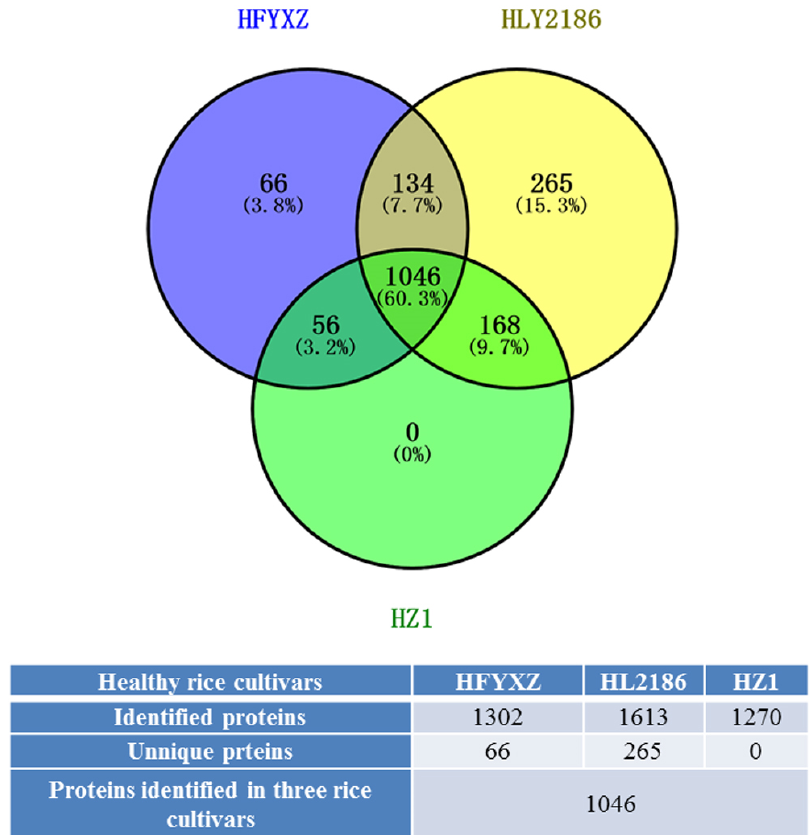
Figure 6. Distribution and overlap of rice proteins identified in healthy rice varieties. Blue circle: healthy FYXZ cultivars (HFYXZ); Yellow circle: healthy L2186 (HL2186); Green circle: healthy Z1 (HZ1).